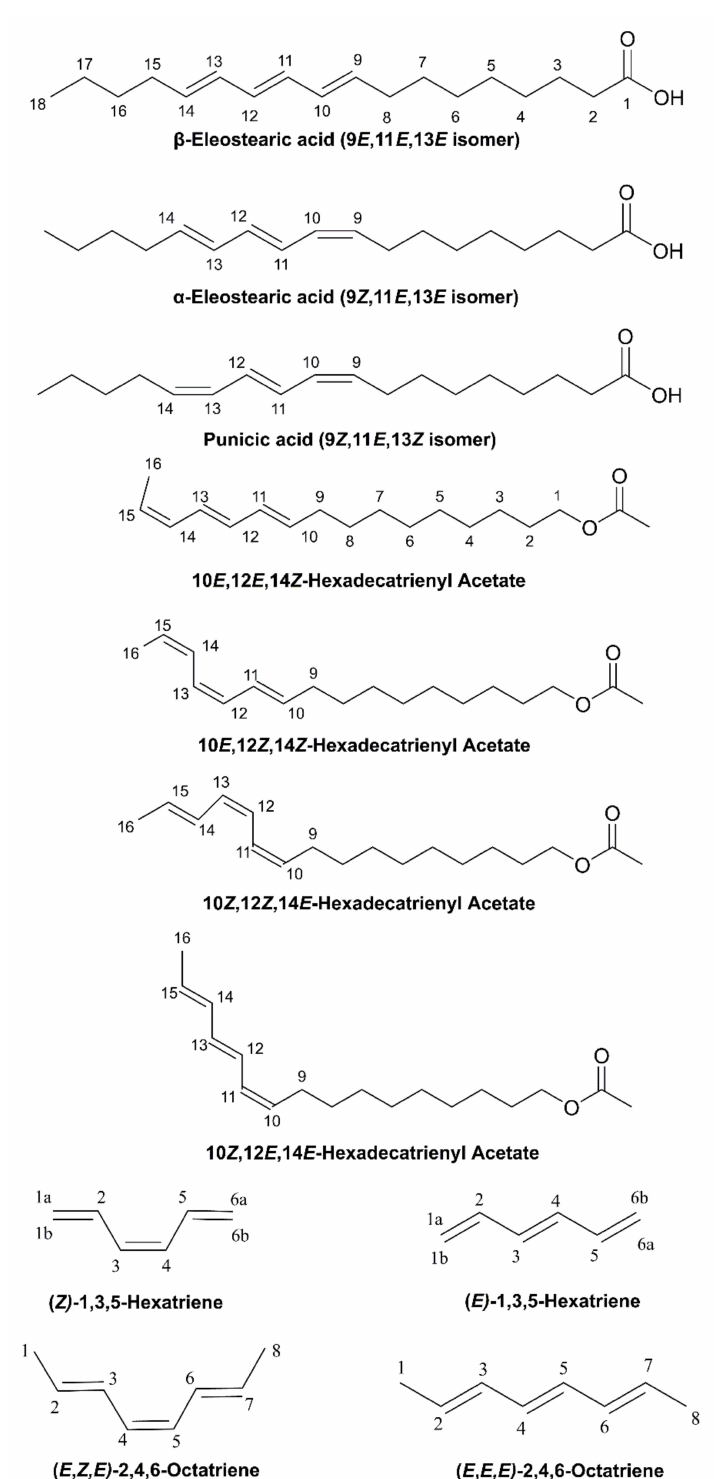
Figure 1. Chemical structures of three geometric isomers of the 18:3 ω -5 conjugated linolenic acid, four geometric isomers of the 16:3 ω -2 conjugated hexadecatrienyl acetate, and triene-containing model compounds investigated in the present